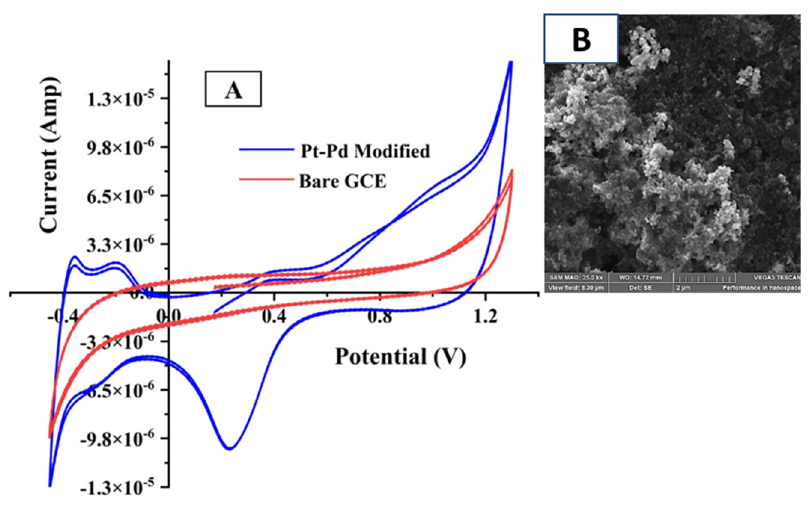
Figure 1. ( A ) Cyclic voltammograms of bare and of Pt-Pd-modified glassy carbon electrodes in BR buffer (pH 2.0). Scan rate = 50 mVs − 1 . ( B ) SEM image of Pt-Pd composite blended with black carbon.